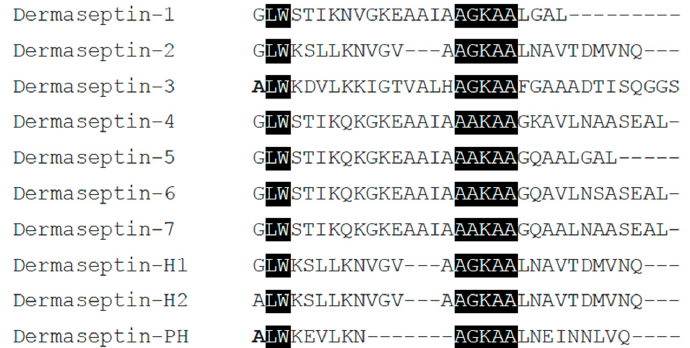
Figure 3. Alignments of amino acid sequences of Dermaseptin-1 (Accession No. P84596), Dermaseptin-2 (Accession No. P84597), Dermaseptin-3 (Accession No. P84598), Dermaseptin-4 (Accession No. P84599), Dermaseptin-5 (Accession No. P84600), Dermaseptin-6 (Accession No. P84601), Dermaseptin-7 (Accession No. P84880), Dermaseptin-H1 (Accession No. Q0VZ36), Dermaseptin-H2 (Accession No. Q0VZ37) and Dermaseptin-PH derived from the frog Pithecopus hypochondrialis are displayed. The identical amino acids are shaded in black; the amino acid with slight changes are indicated in bold type; the gaps are used to maximise alignments.